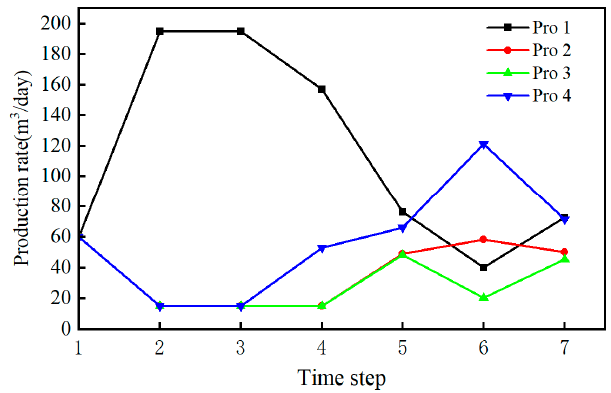
Figure 17. Production optimization in the single-layer model with a block-like permeability strip.